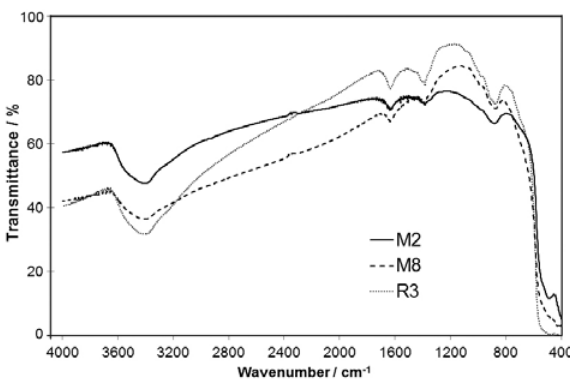
Fig. 3. FT-IR spectrum of obtained